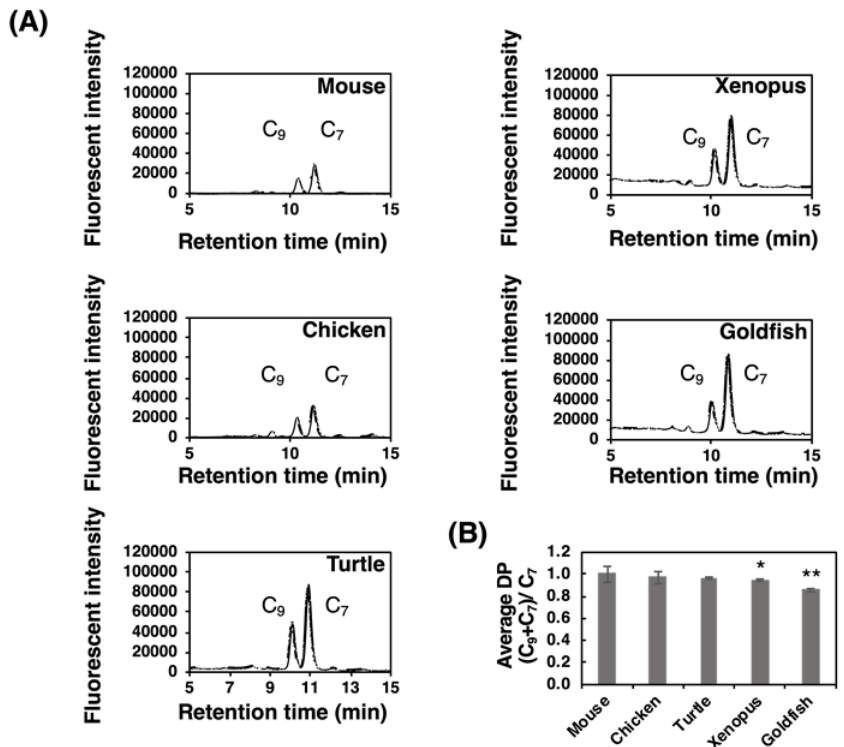
Figure 7. Fluorometric C 7 / C 9 analysis of brain homogenates of five di ff erent vertebrate brains. Brains from five vertebrates (mouse, chicken, turtle, xenopus, and goldfish, n = 3) were used. Brain homogenates (20 µ g as protein) were subjected to the fluorometric C 7 / C 9 method to measure the average degree of polymerization (DP). ( A ) Typical chromatograms of C 7 / C 9 analysis of each brain. ( B ) Relative (C 7 + C 9 ) / C 7 index in each brain. * indicates p < 0.05. ** indicates p < 0.01. Mouse value was set to 1.0.